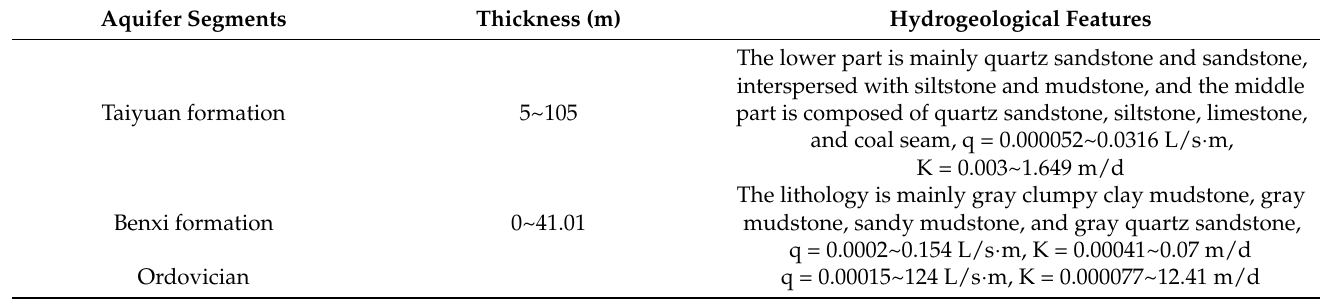
Table 3. Hydrogeological characteristics of fractured aquifers in Carboniferous and Ordovician sandstone (limestone).